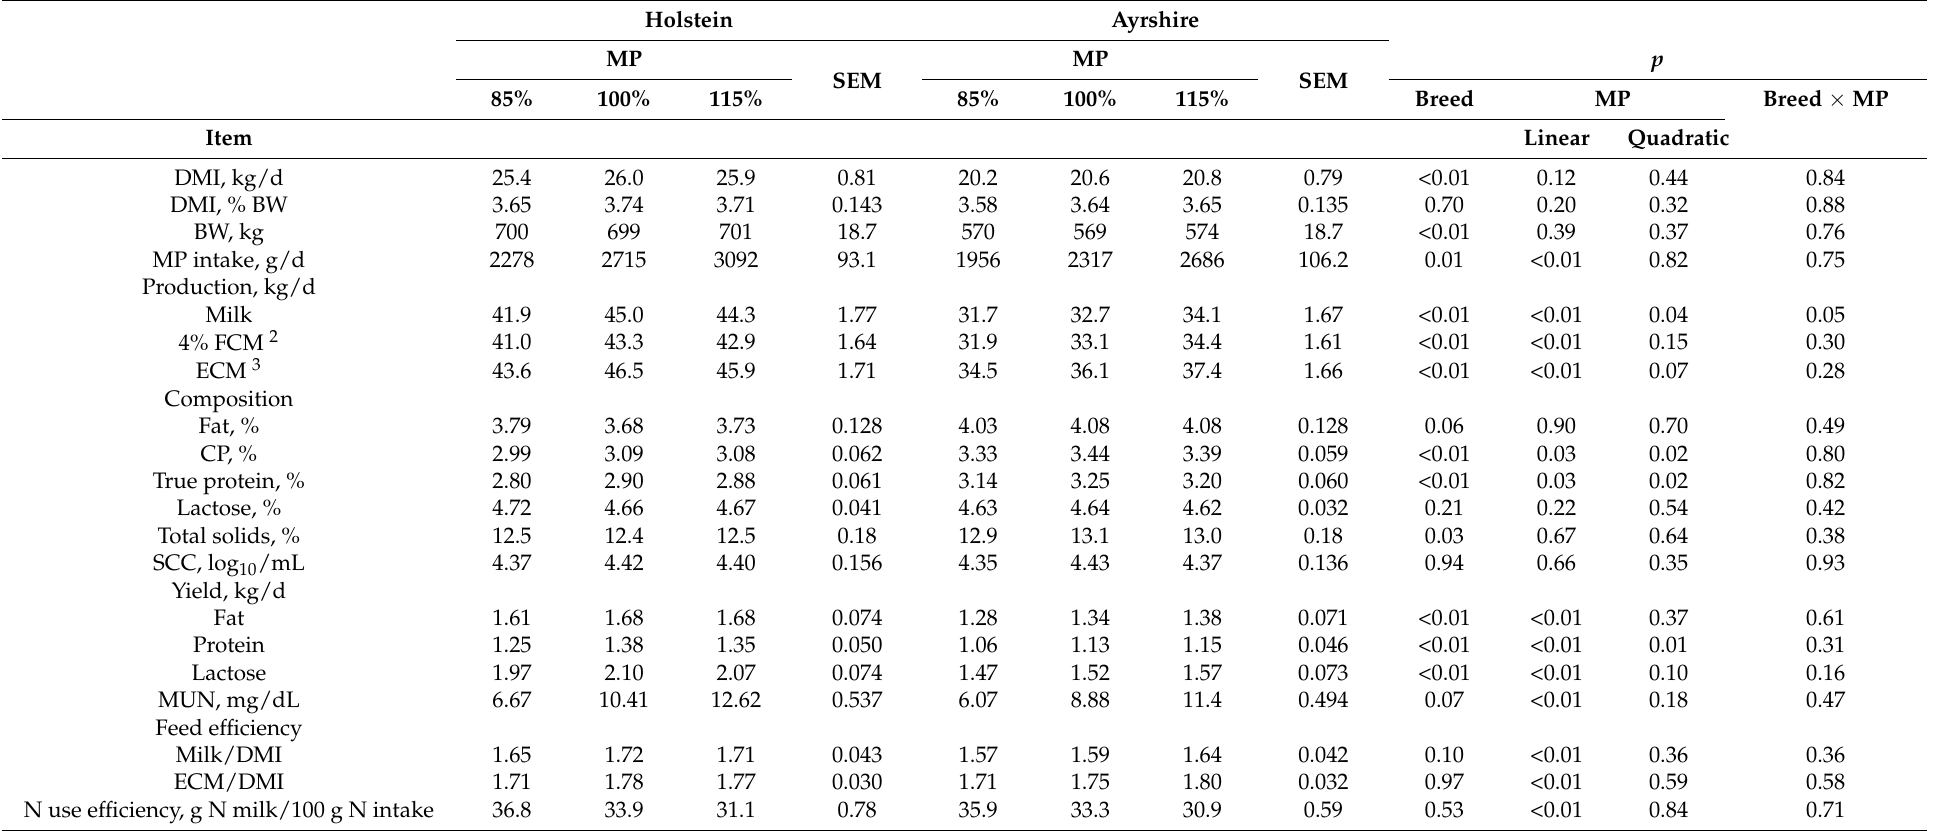
Table 2. Dry matter intake, milk production, and milk composition of lactating Holstein and Ayrshire cows fed diets formulated to provide 85%, 100%, or 115% of metabolizable protein (MP) requirement 1